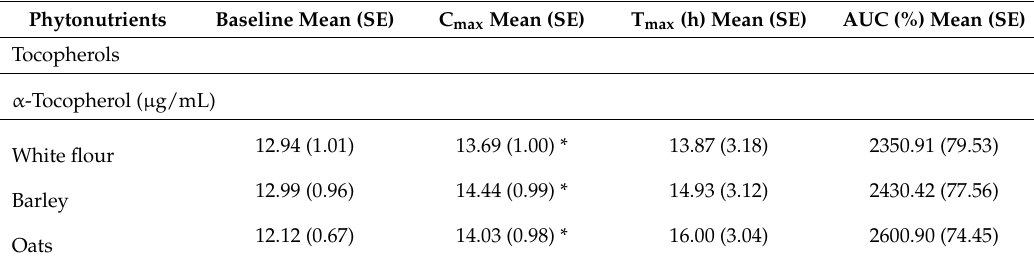
Table 3. Plasma pharmacokinetics of phytochemicals in humans consuming muffins made with whole oat, whole barley or refined wheat flour (0–24